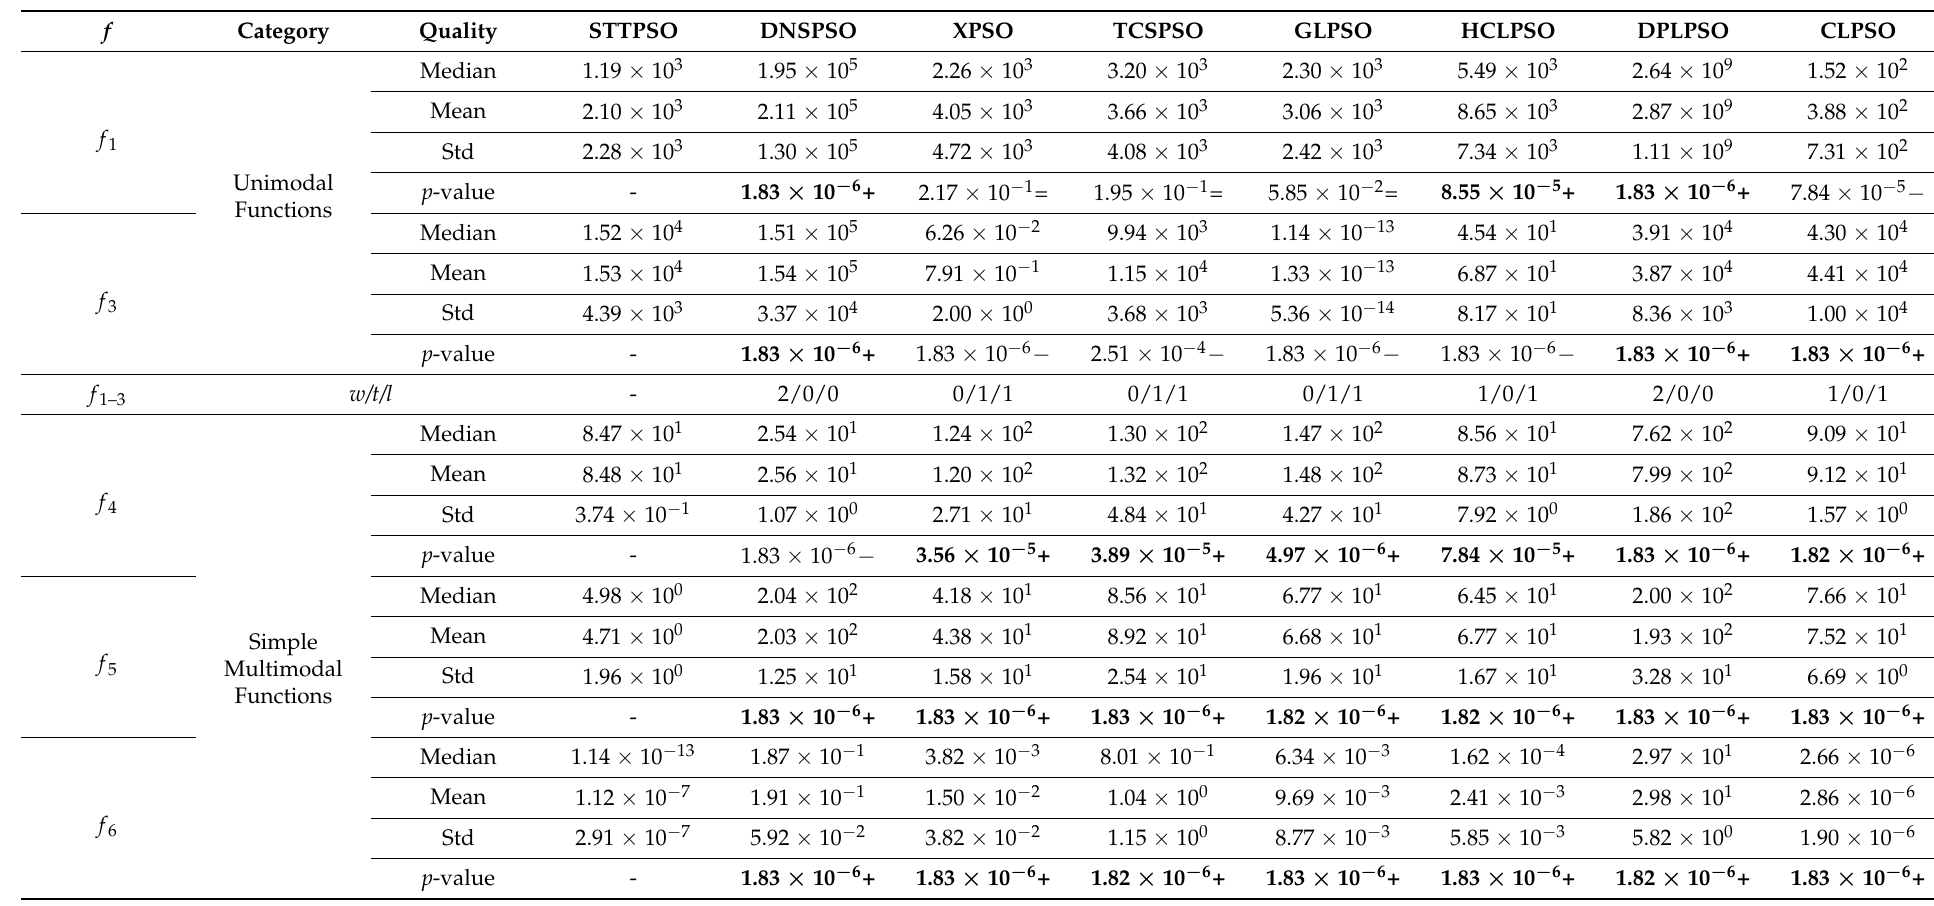
Table 3. Comparison results between the proposed STTPSO and the 7 state-of-the-art and popular PSO variants on the 30- D CEC 2017 benchmark functions. The highlighted p -values means that the proposed STTPSO is significantly better than the associated compared algorithms on the corresponding